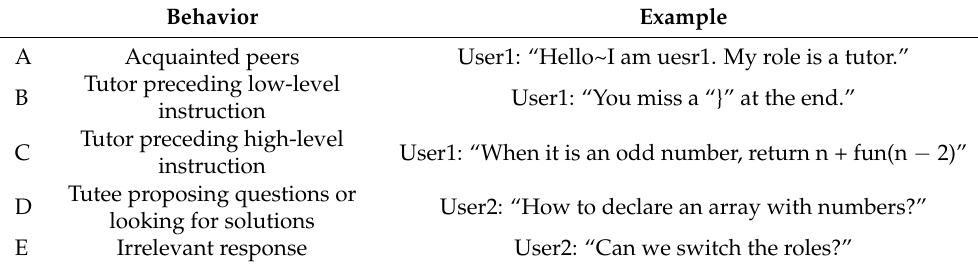
Table 1. Chat room information